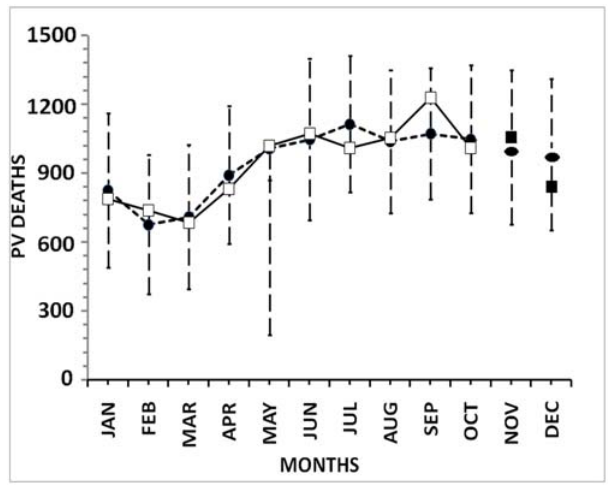
Figure 5. The plot of fit of the predicted values to the observed data of P.vivax Deaths. Straight line with white squares-observed values of P.vivax Deaths; Dashed line with black circles-predicted values of P.vivax Deaths from the model. Error bars are of 95% confidence intervals of the predicted response. Black ellipses-forecasted values of P.vivax Deaths and Black squares-observed values of P.vivax Deaths for November and December, 2006.